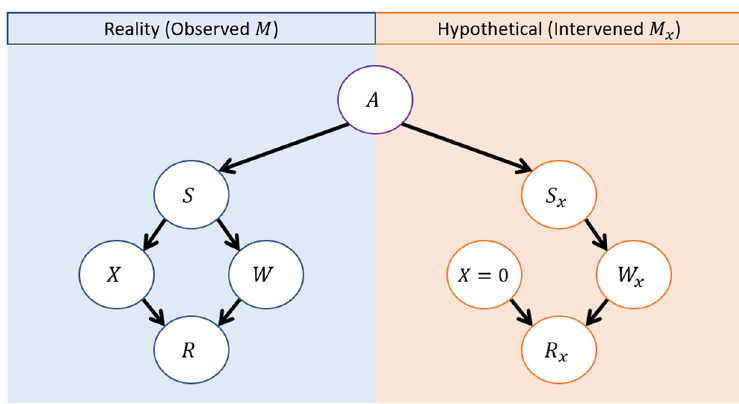
Figure 9: Twin network M ∗ for the SCM in Example 5.1 and counterfactual query P